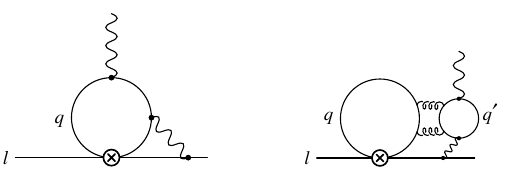
Figure 3 . Contributions of the semileptonic scalar operators to the lepton dipole. The right-hand diagram starts at four-loop order in perturbation theory. However, for light quarks, it gives a non- perturbative contribution to the dipole that is not suppressed by loop factors in comparison to the left-hand